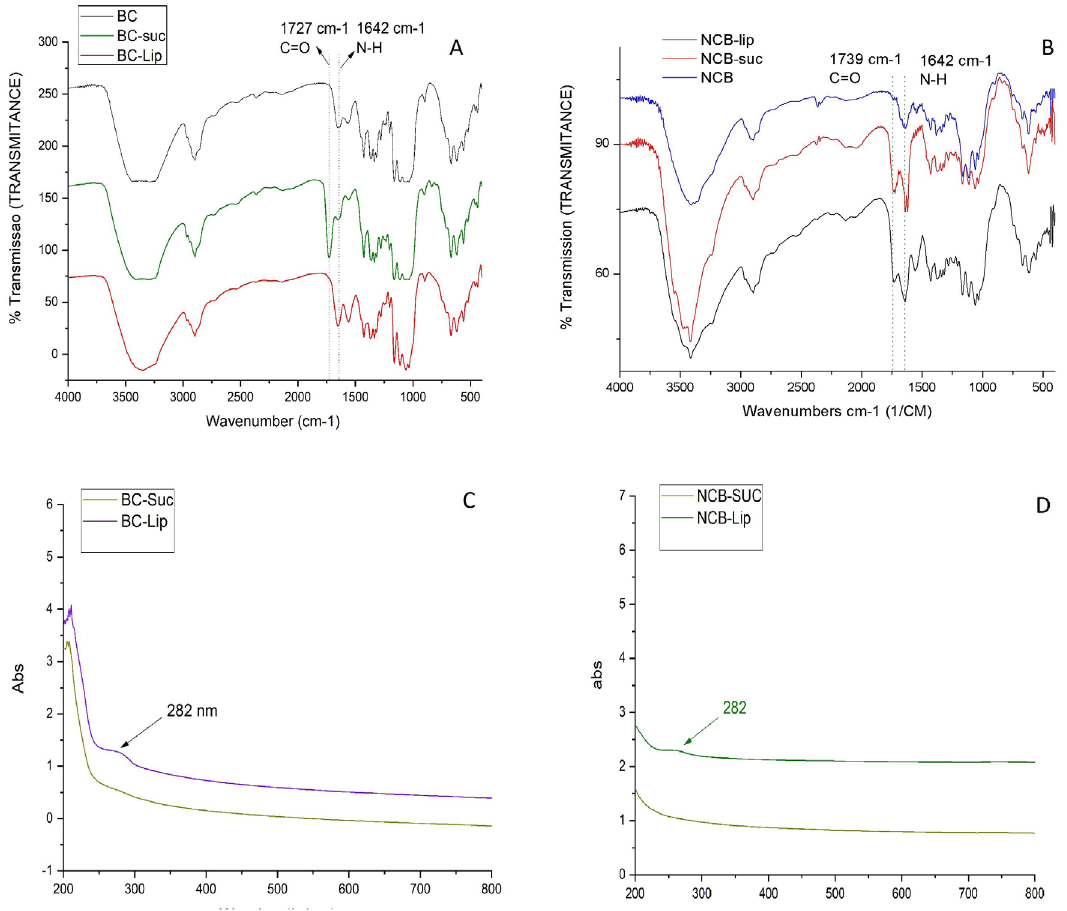
Figure 1. (A) Infrared Spectrum (FTIR) of native cellulose membrane BC, succinylated BC-suc and immobilized Lipase BC-lip. (B): Infrared Spectrum (FTIR) of succinylated nanocellulose. (C) UV-vis Spectrum of succinylated membrane and immobilized lipase. (D) UV-Vis Spectrum of succinylated nanocellulose and immobilized lipase.